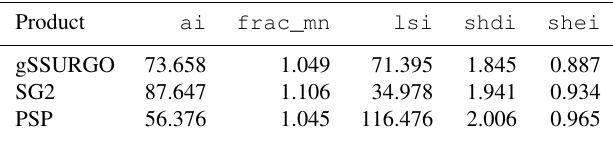
Table 8. Landscape metrics statistics (local) for pH at 0–5cm. frac_mn is the mean fractal dimension, lsi is the landscape shape index, shdi is the Shannon diversity, shei is the Shannon evenness, and ai is the aggregation index.